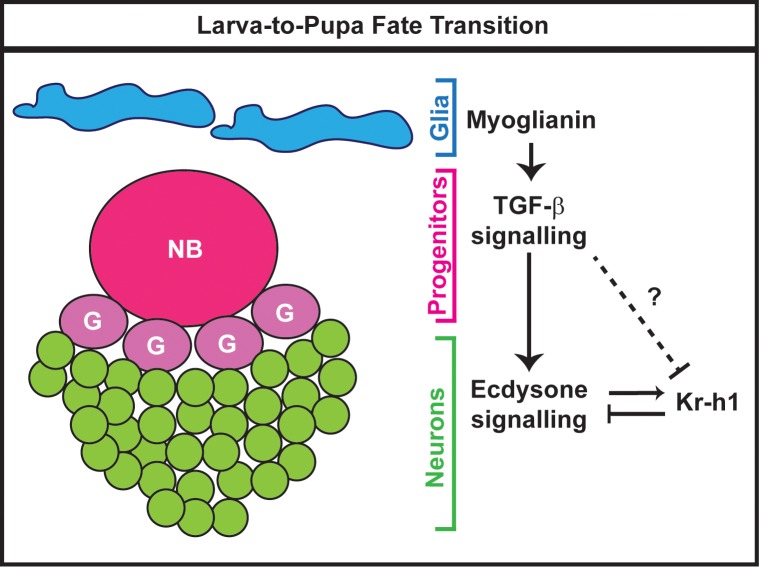
Model of ecdysone signalling modulation during the transition from α’β’ to p. αβ MB fate.The fate switch between early-born MB neurons (γ and α’β’) versus late-born MB neurons (p. αβ and αβ) occurs during the developmental transition from larval stage to metamorphosis. During this developmental time window, the Myoglianin ligand released from glial cells activates the TGF-β signalling in MB progenitors. As a result, the postmitotic MB neurons (green) are now capable of sensing the circulating hormone ecdysone. In turns, ecdysone signalling regulates the expression of Kr-h1 which negatively tunes ecdsyone response. The question mark reflects the possibility of a direct regulation of Kr-h1 by TGF-β signalling. NB, neuroblast; G, ganglion mother cell.